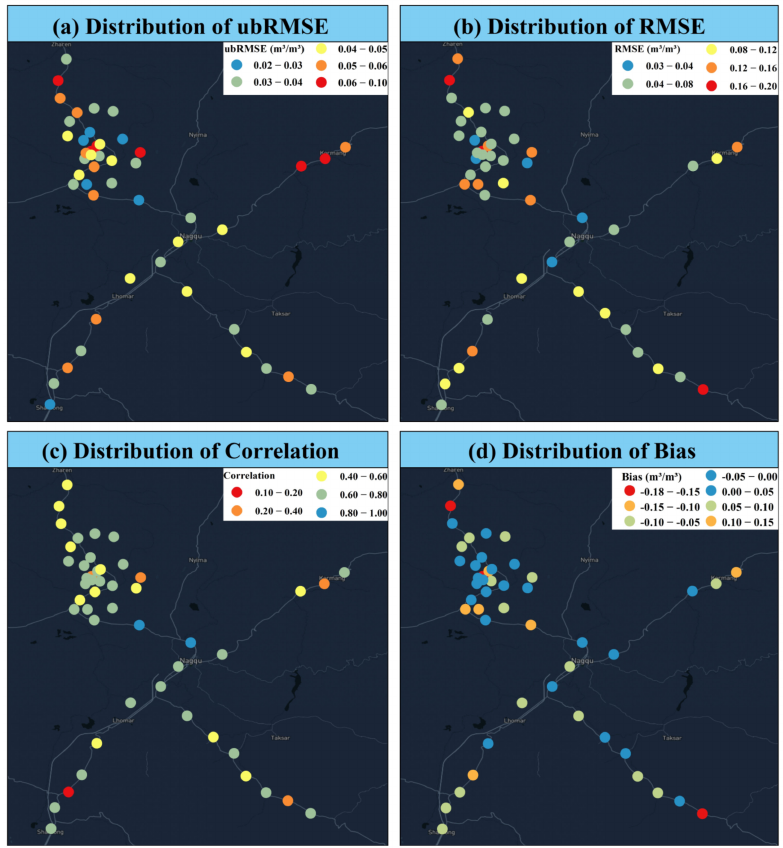
Figure 10. Spatial distributions of ( a ) ubRMSE, ( b ) RMSE, ( c ) Correlation, and ( d ) Bias for the merged SM against in situ SM